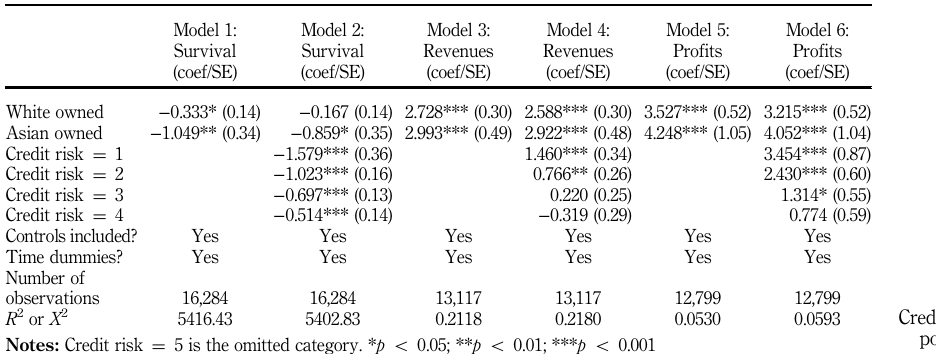
Table IX. Credit risk mediation pooled